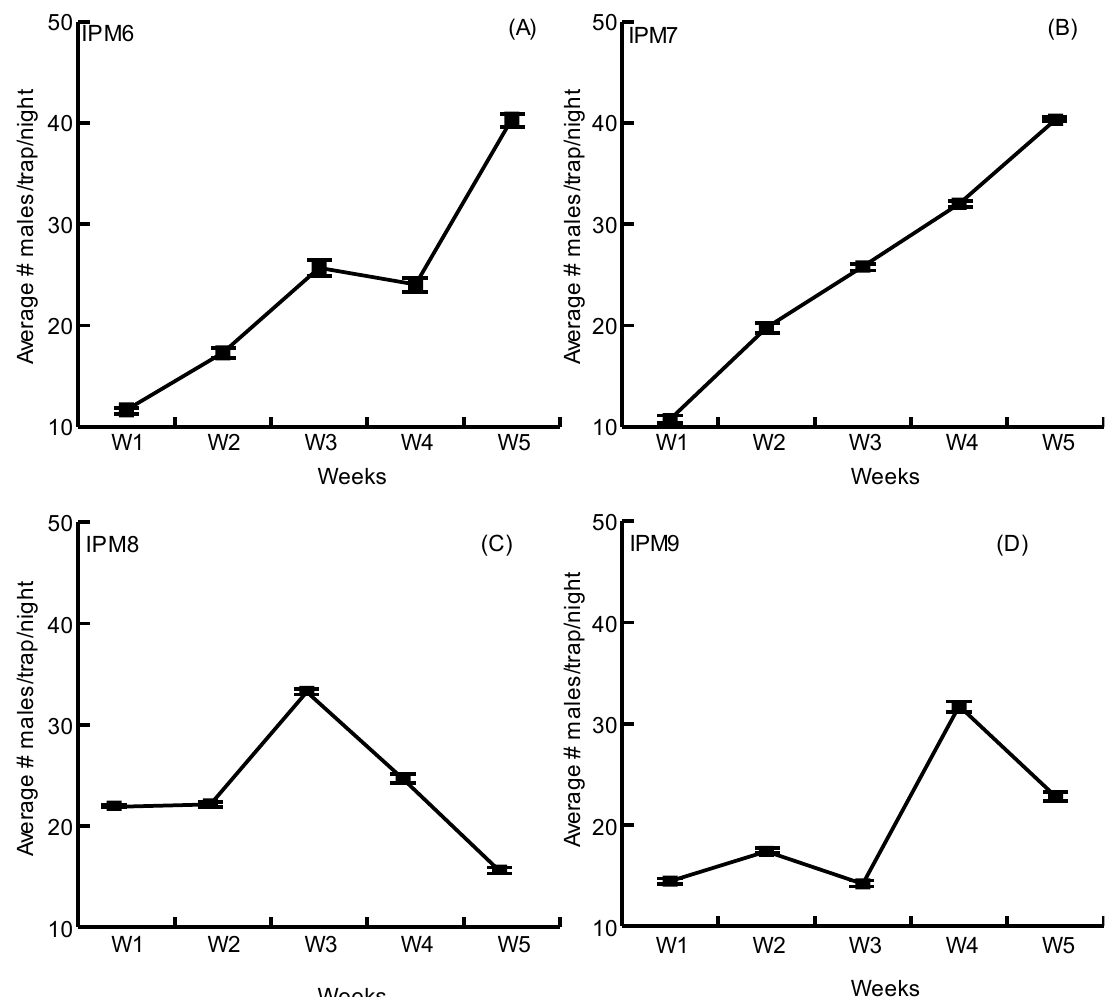
Figure 2. Average DBM male captures in IPM plots of four farms in Nicaragua ( A – D ). Standard error bars are shown for each evaluation.